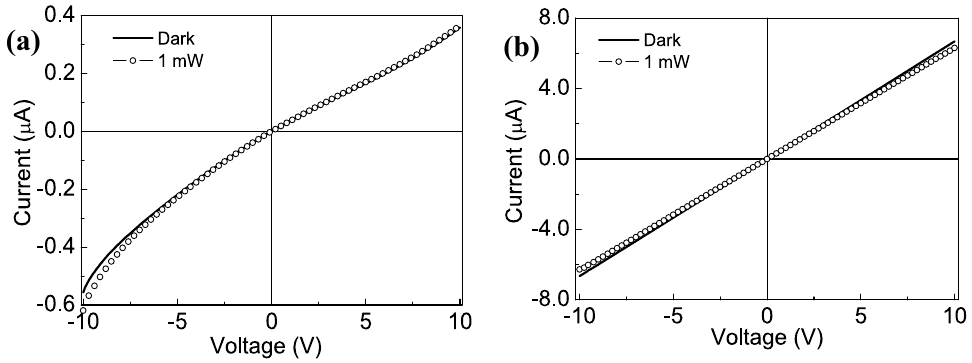
Figure 3. I–V characteristics of GO ( a ) and rGO ( b ), deposited on glass substrate and measured in dark conditions and using a 378 nm laser light tuned at 1mW.